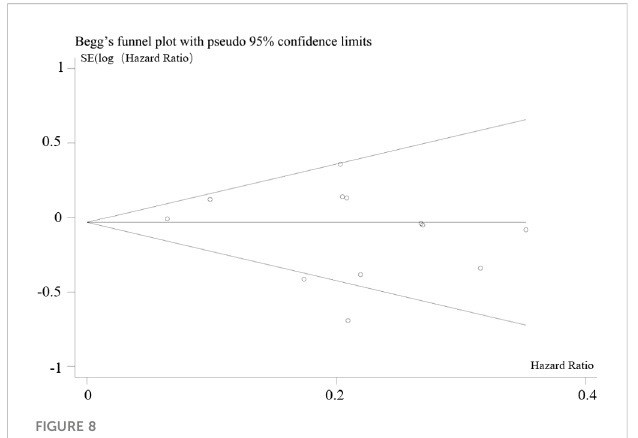
FIGURE 8 Begg ’ s funnel plot of hazard ratios for overall survival (OS).